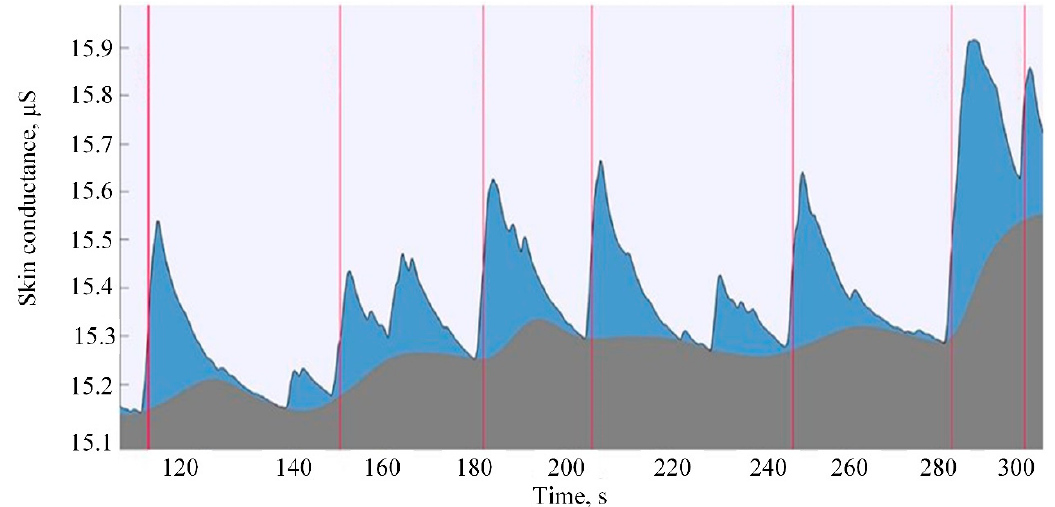
Figure 7. Example of raw GSR signal. The blue area indicates the phasic component of the signal; grey area represents the tonic component. The red line indicates the trigger (moment of delivery of the stimulus).[88].